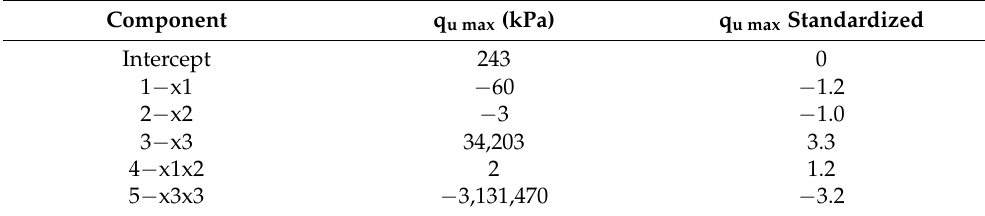
Table 6. Regression coefficients for the q u max model.